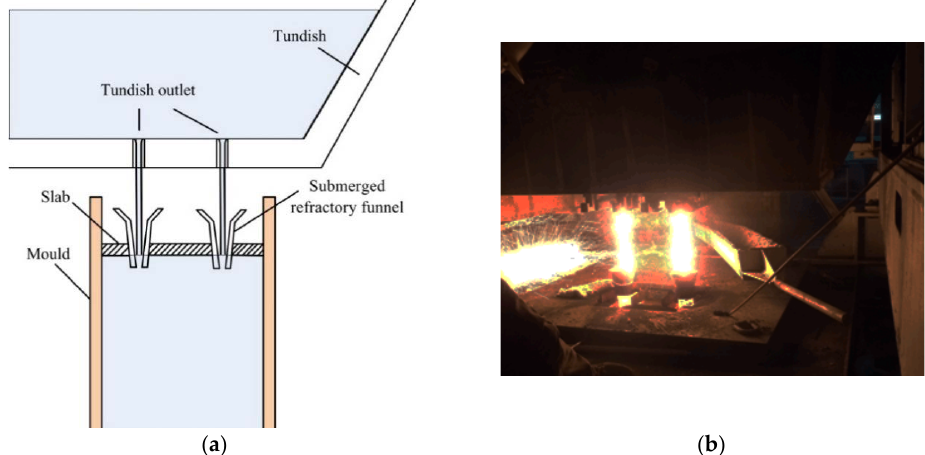
Figure 1. Schematic illustration ( a ) and photo ( b ) of beam blank mold using semi-open pouring combined with submerged refractory funnels.